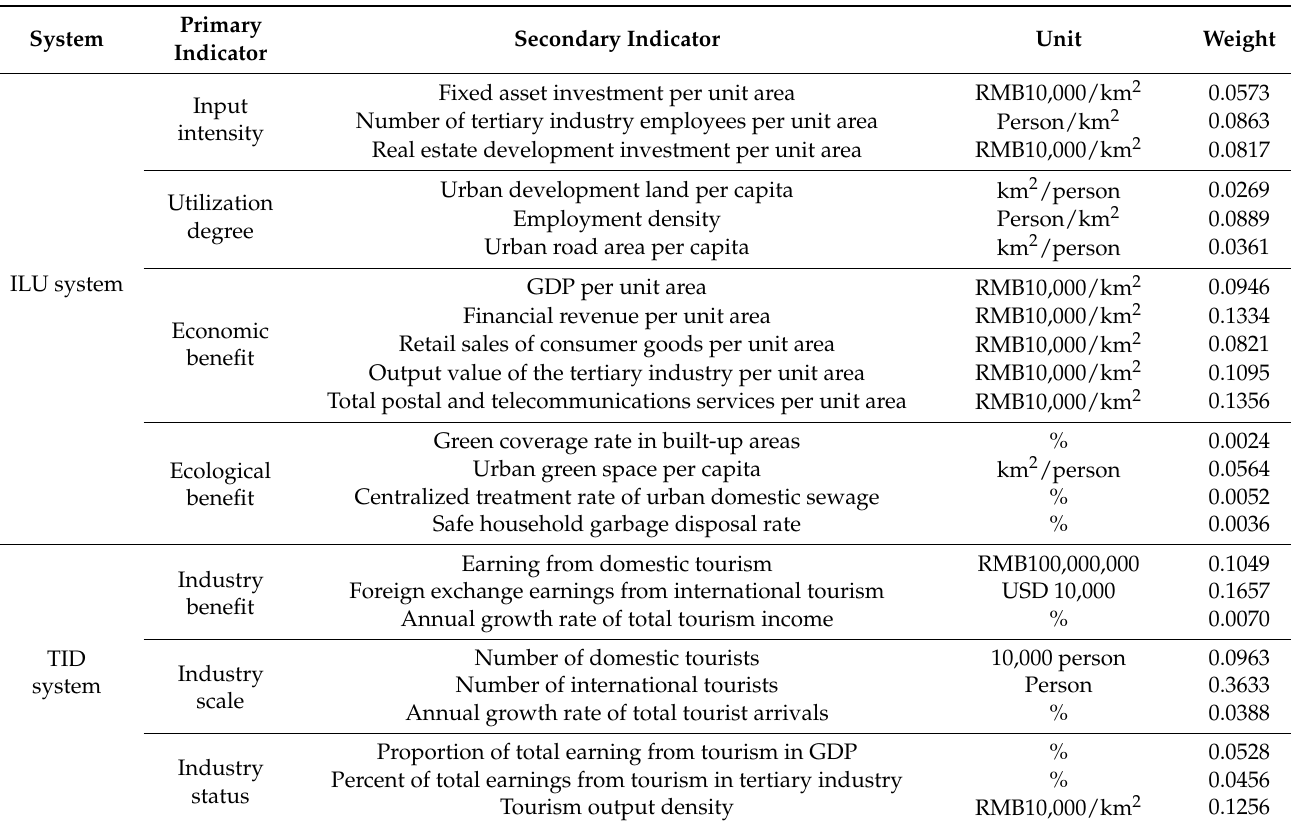
Table 1. Evaluation index system of ILU and